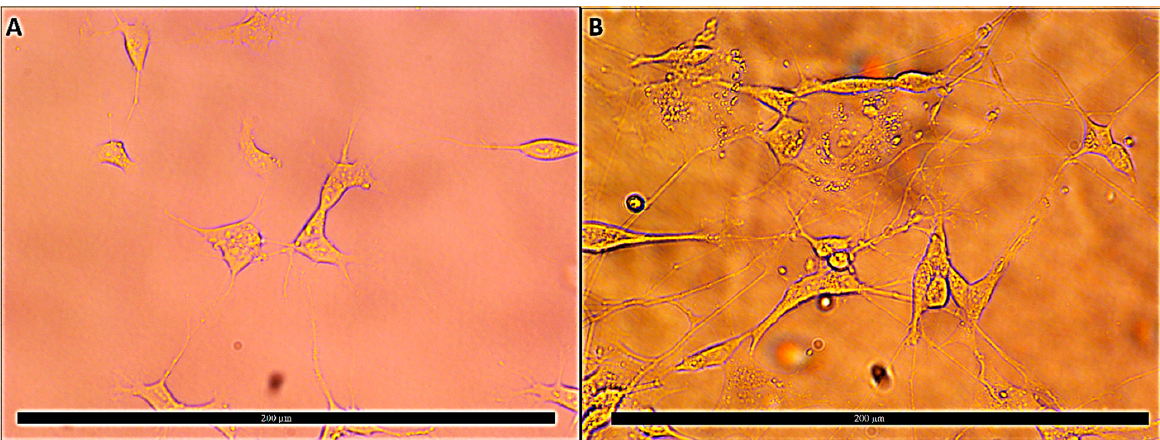
Figure 5. 40x image of normal and differentiated SHSY-5Y cells. ( A )—Undifferentiated SHSY-5Y cells and ( B )—differentiated SHSY-5Y cells.